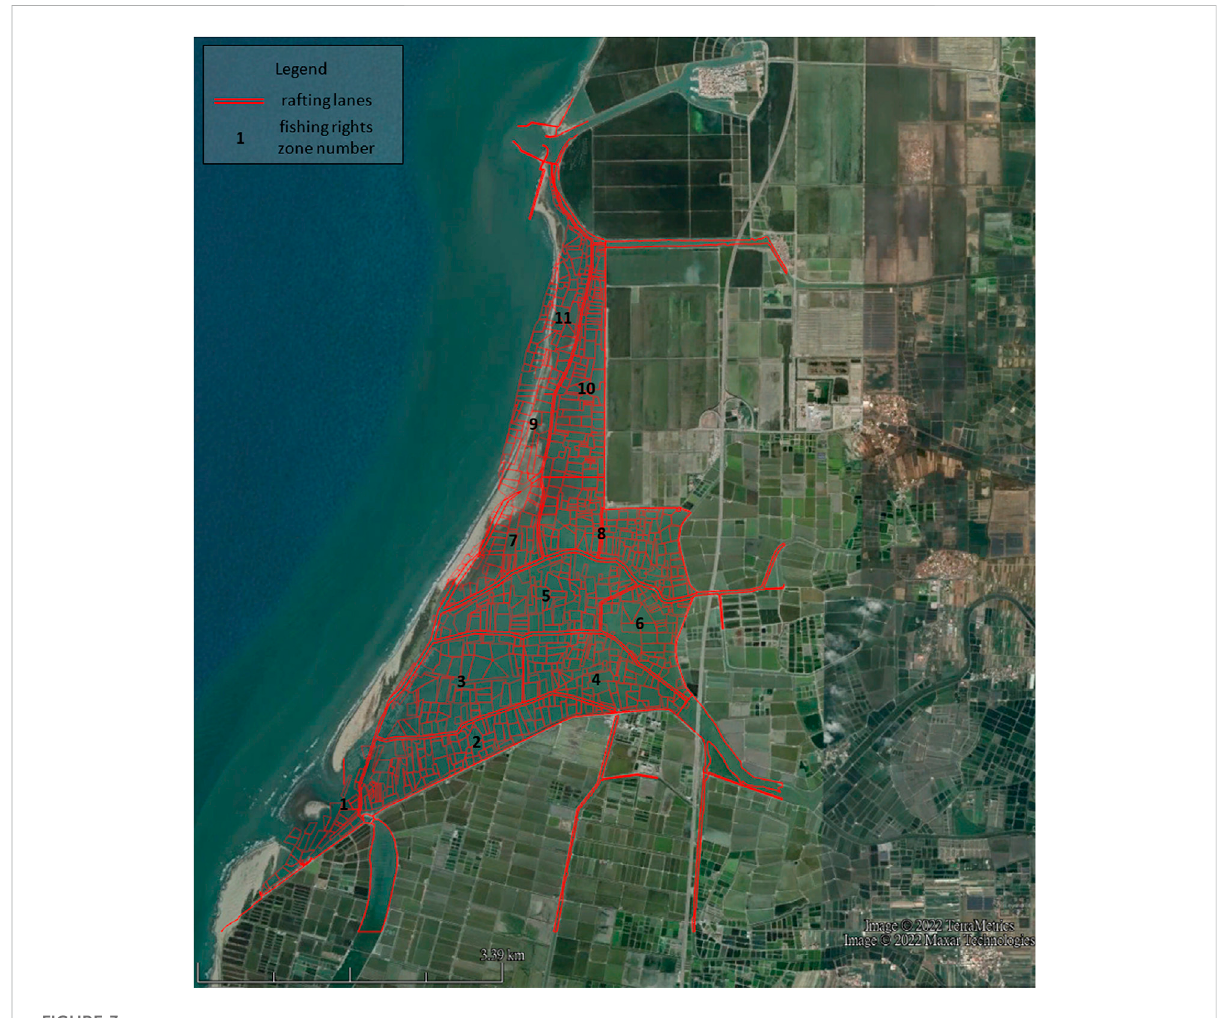
FIGURE 3 Map of the fi shing rights zones and rafting lanes in Cigu